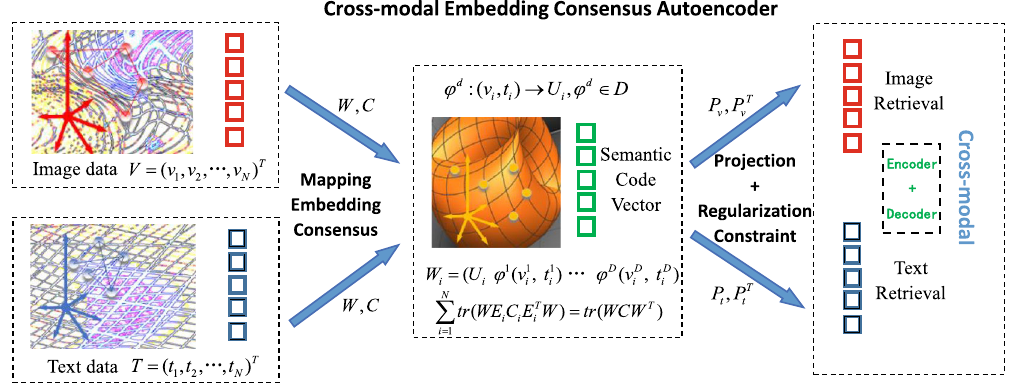
Figure 4. The process of CSAEC. We map the datasets to an embedding space, learn projections by multi- modal semantic autoencoder and reconstruct original features. ( V T ) is the original data matrix, U i is a low- d dimensional consensus vector of embedding consensus ϕ , W is a low-dimensional embedding matrix, C is the corresponding semantic code. Two encoders P v , P t project image and text data into low-dimensional space A , and two decoders reproject A back to high-dimensional